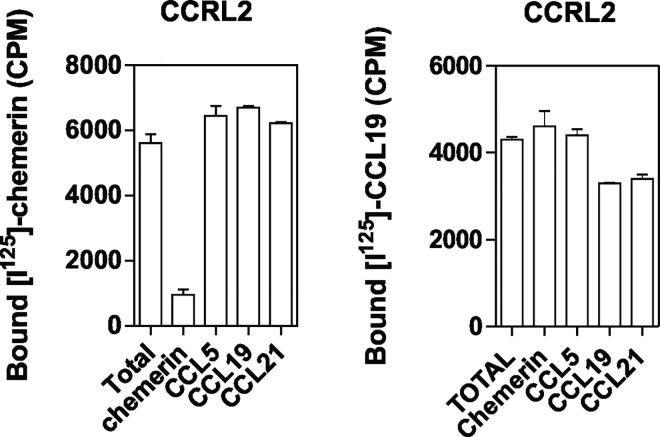
Chemokine binding to CCRL2.CHO-K1 cells expressing CCRL2 were incubated with 0.1 nM [125I]-chemerin (A) or 0.1 nM [125I]-CCL19 (B) in combination or not with an excess of unlabeled chemerin, CCL5, CCL19 or CCL21 (300nM). All points were run in triplicates (error bars indicate S.E.M.).